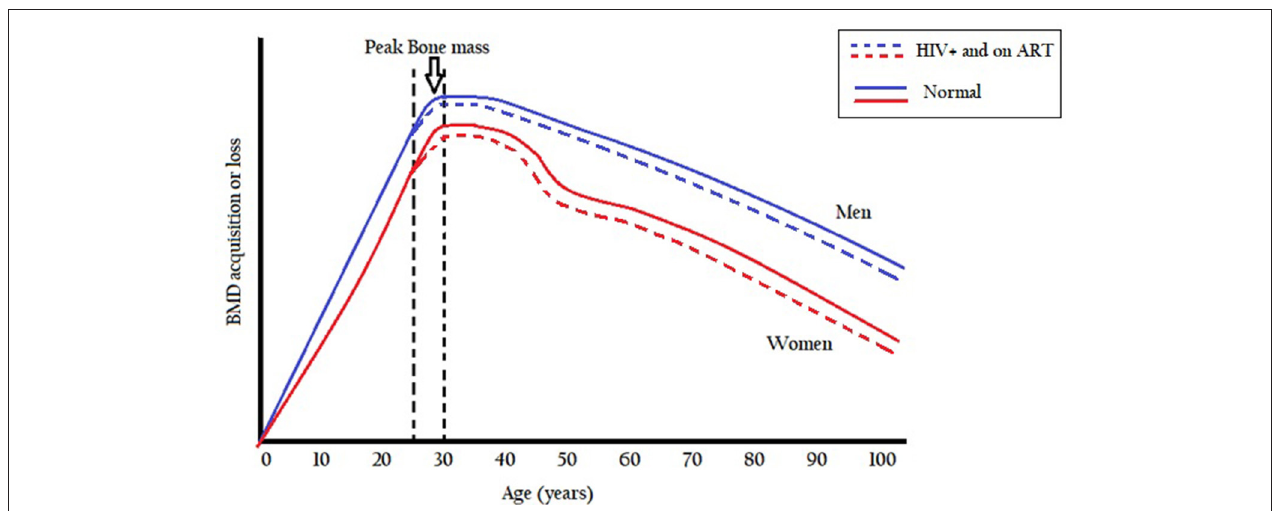
FIGURE 1 | Bone mass